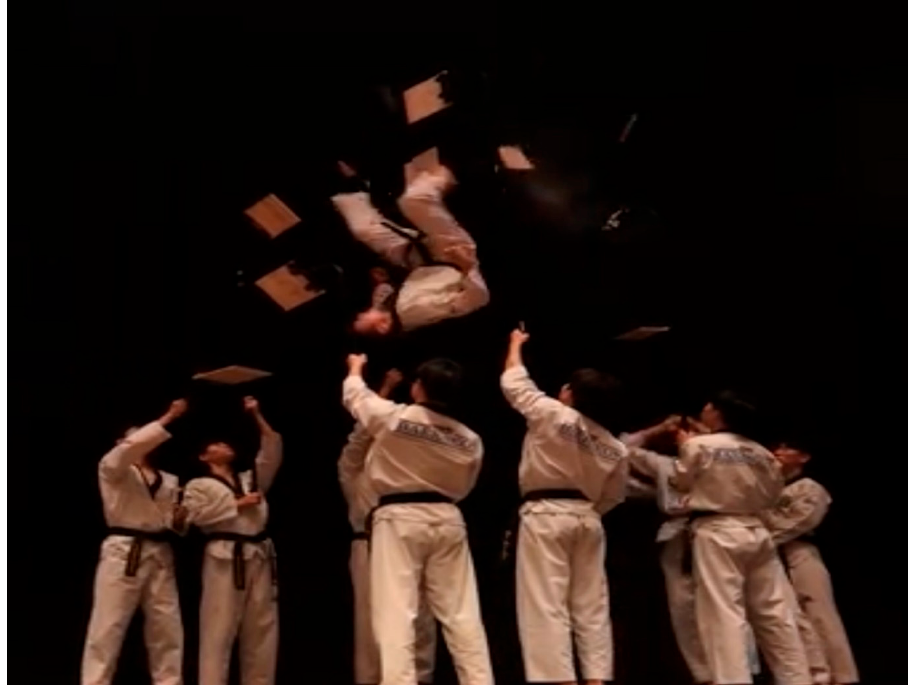
Figure 2. Participant’s successful spin-breaking scene in 18 December 2020.